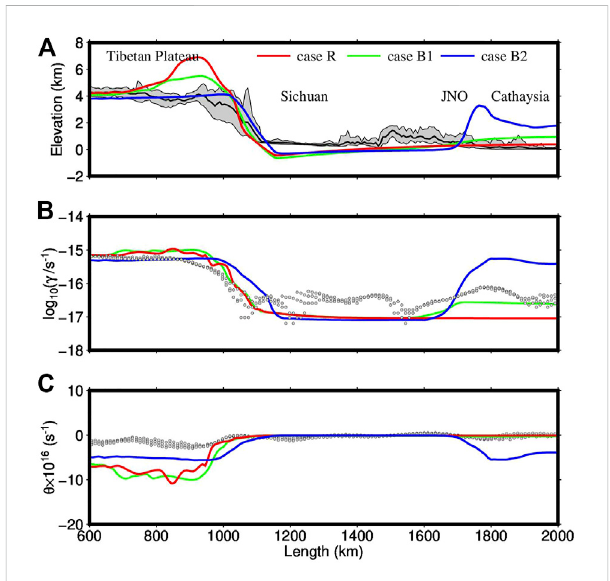
FIGURE 7 Comparisons of the numerical models (cases R, B1, B2) with the observed surface topography (A) , the maximum shear strain rate (B) , and the dilatation strain rate (C) across the eastern margins of the Tibetan Plateau (BB ’ pro fi le in Figure 1C), respectively. Gray areas in (A) indicate the observed topographic change. Gray dots in (B – C) indicate the observed strain rates. The data of topography are consistent with those shown in Figure 1. Strain rate data is from (Kreemer et al., 2014; Wang and Shen,